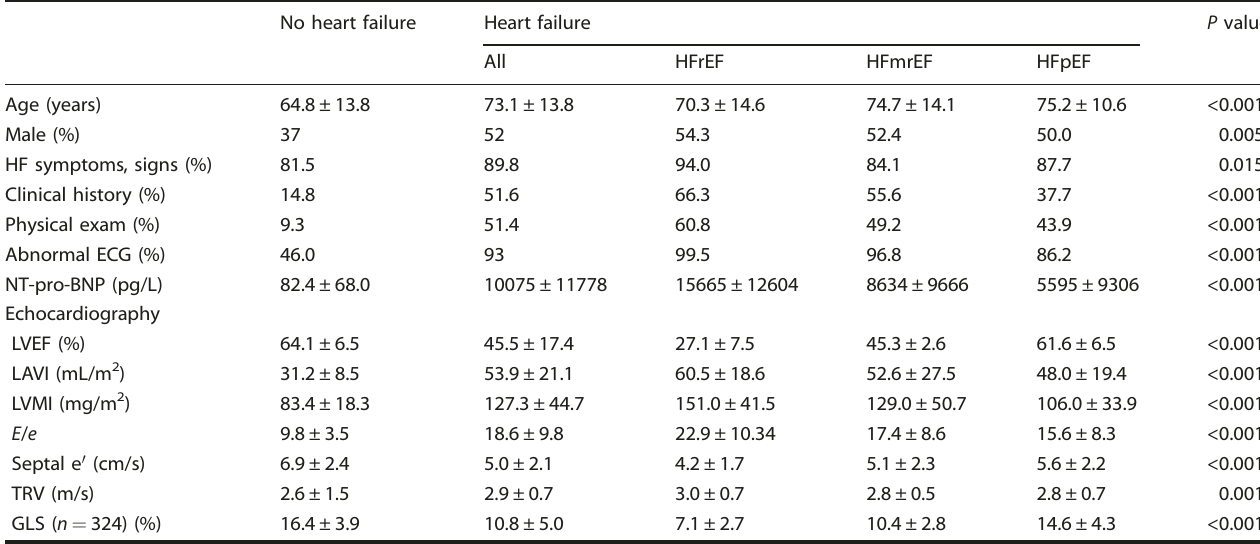
Table 1. Characteristics of the study population retrospective patients ( n = 598).